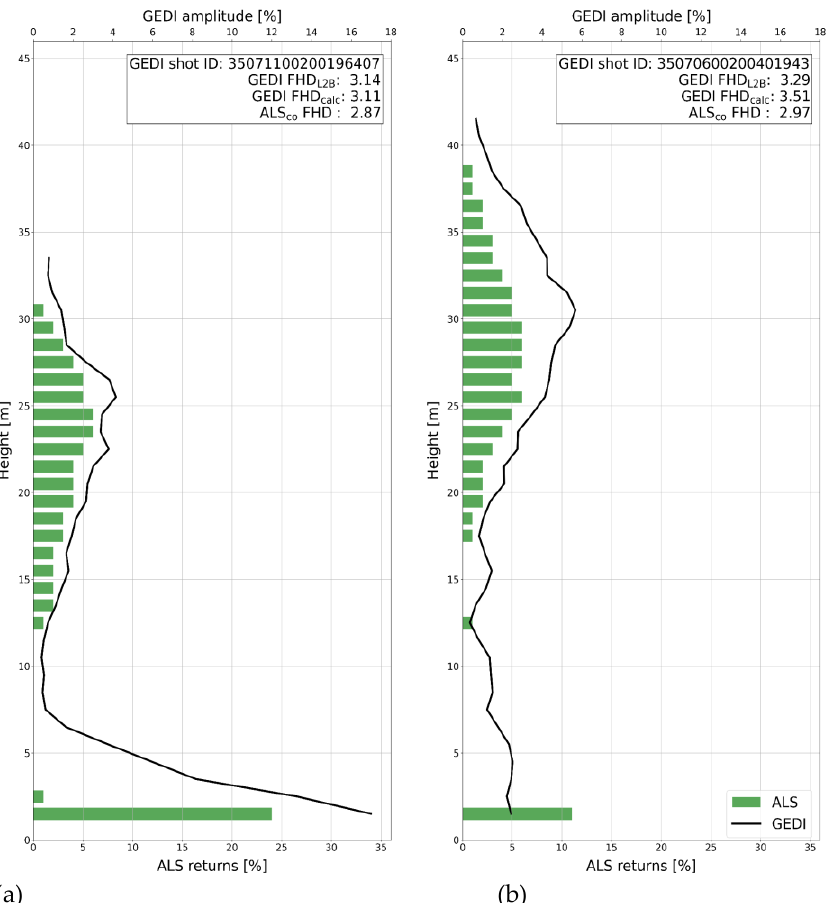
Figure 3. Example plots with GEDI waveforms (black) and ALS returns per height layer (green); further noted are the FHD values from GEDI L2B, calculated from GEDI amplitude and calculated from co-located ALS returns.